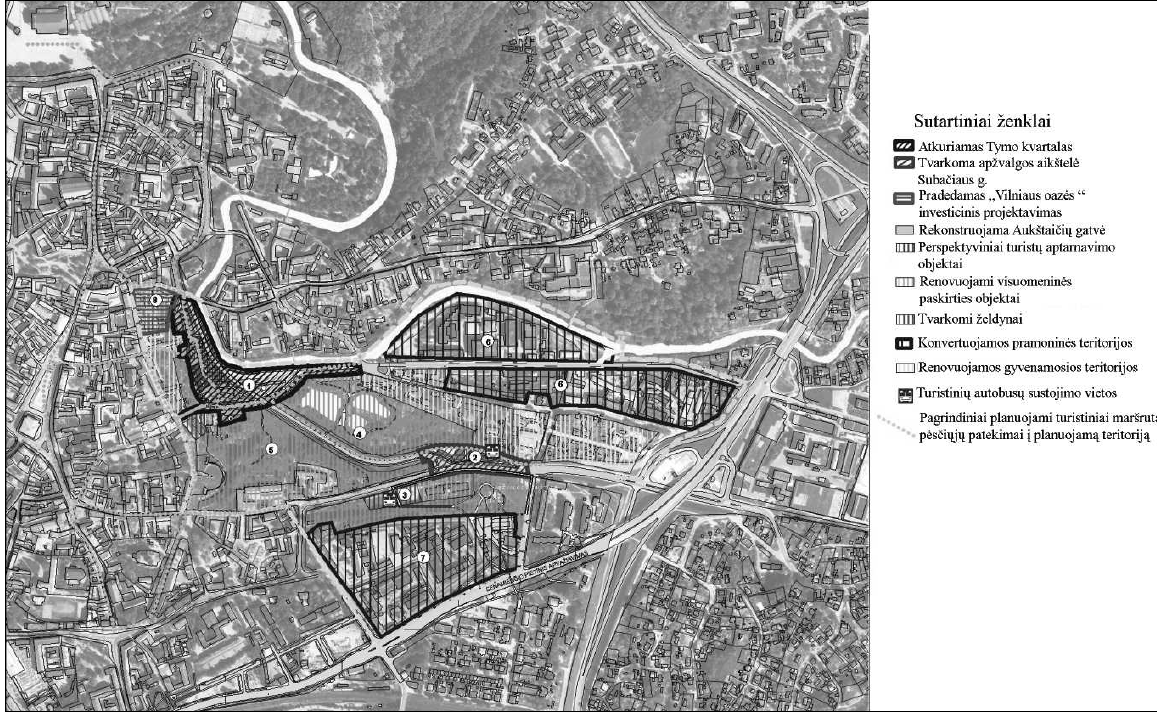
Fig 6. Renewal of Tymas block. The strategy of Tymas block renewal and its nearest surroundings